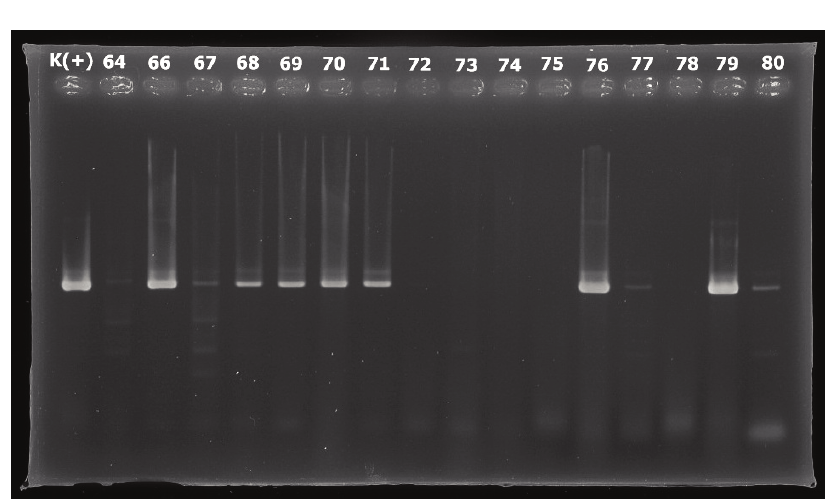
Figure 2. PCR amplification using primer